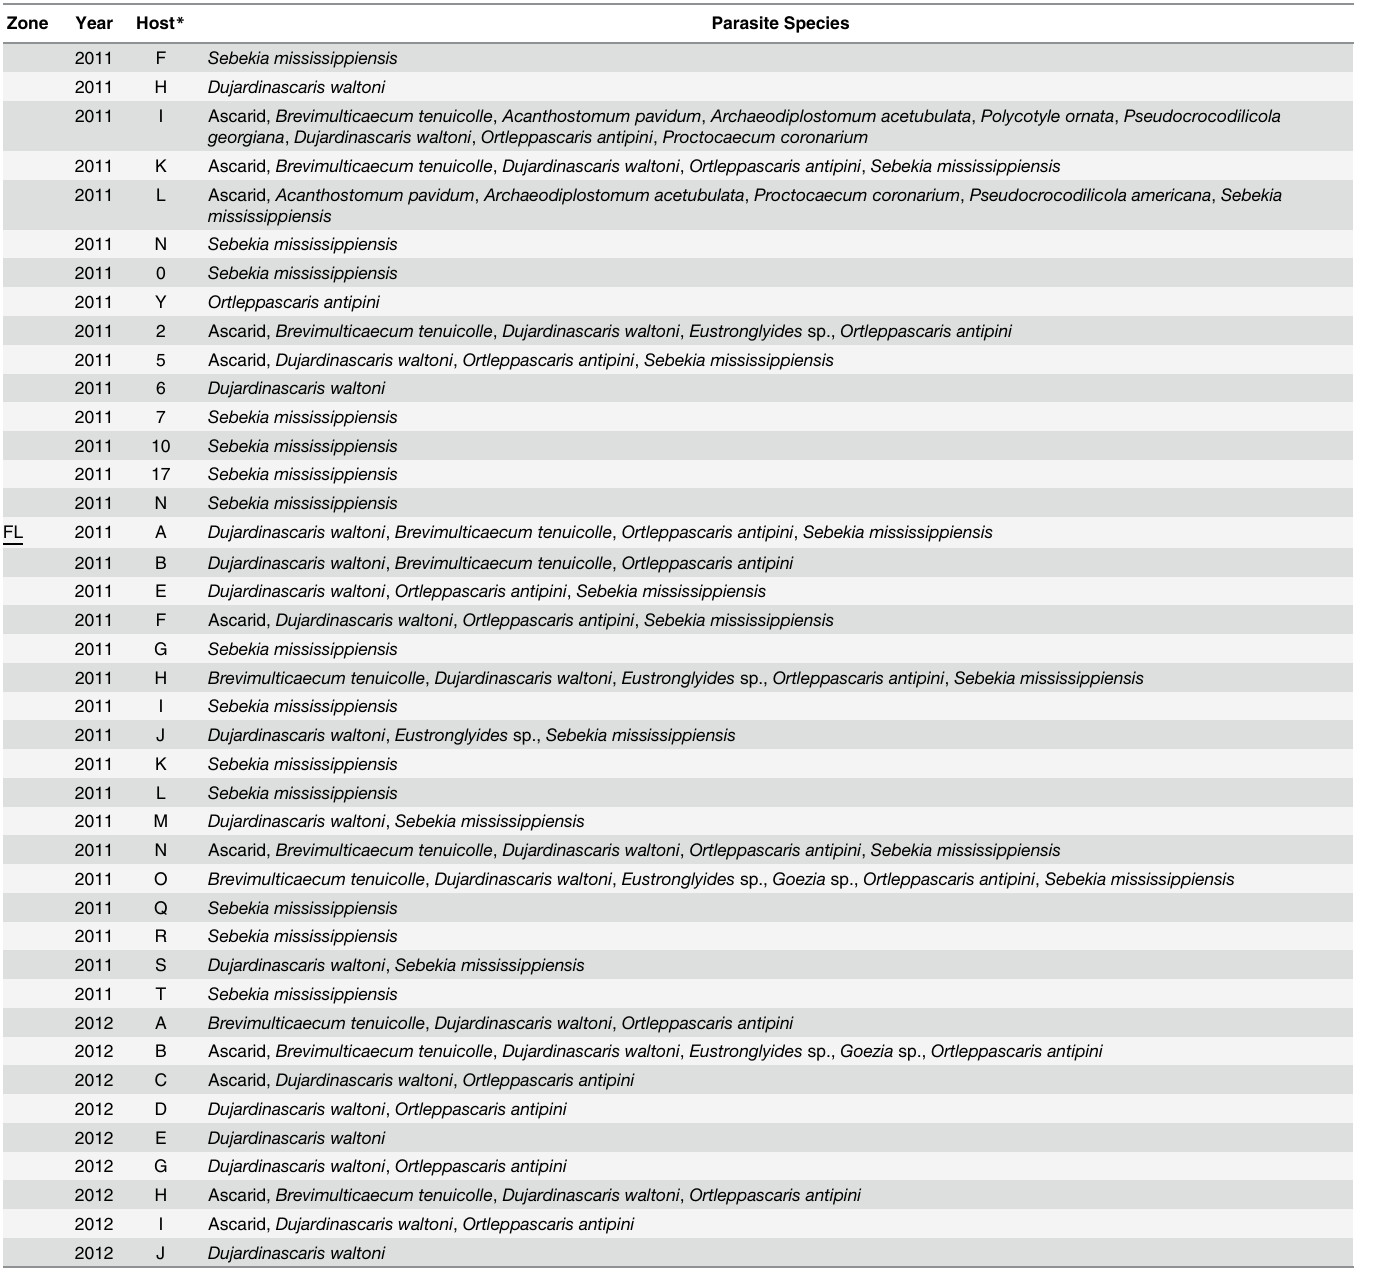
* Numbers and letters under column “ Host ” identi fi es the tag of each alligator individual, i.e., “ Alligator 13 2009, ” Alligator A 2009 ” ,